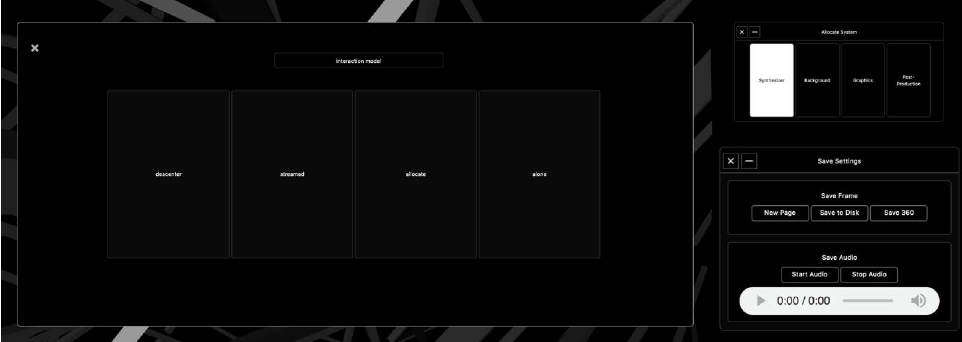
Figure 9: GUI Elements of Akson: 8) Interaction modal; 9) Allocate System; 10) Save